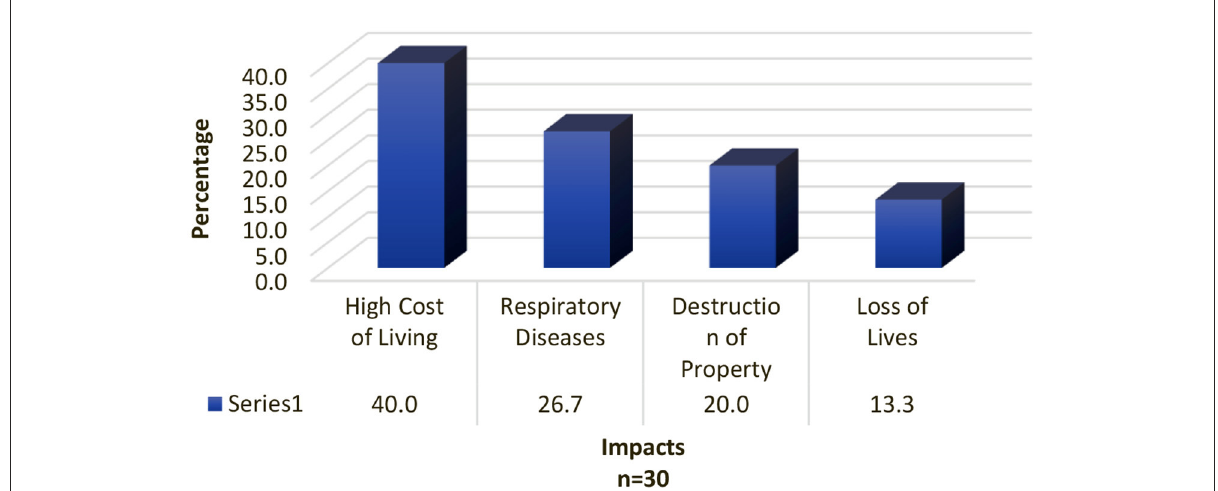
FIGURE2 Impacts of climate change and disasters on the community. Source: Muchiri and Opiyo (2022).